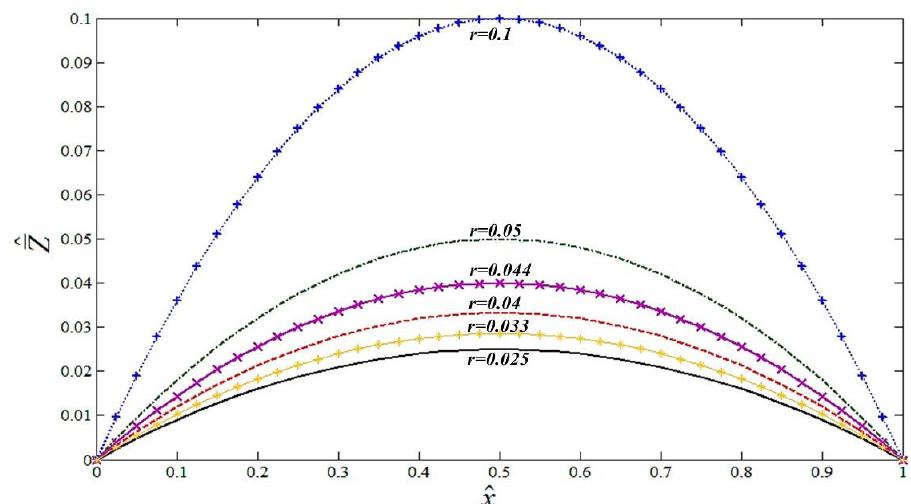
Figure 2. The quadratic curve with different waviness considered for the structure.